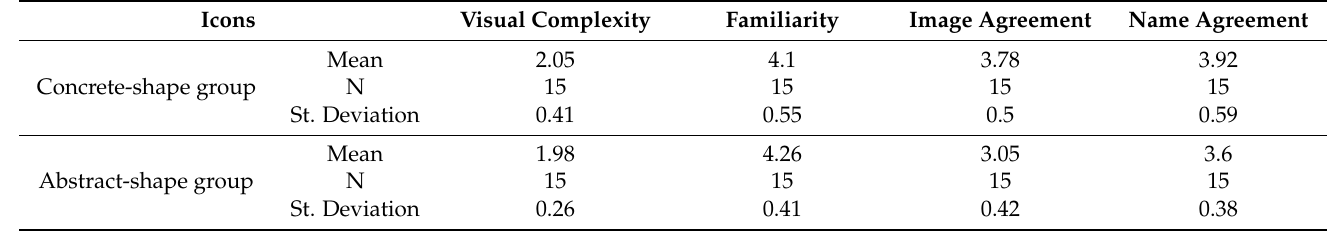
Table 1. The cognitive characteristics score of concrete-shape group and abstract-shape